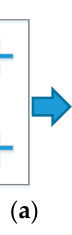
Figure 1. Overview of the hardware of the proposed embedded printed circuit board (PCB) alignment system. ( a , b ) are the top view and the front view of the vision alignment platform, respectively; ( c ) is the location of the PCB in the system; ( d ) is the description of the parameters of the movable platform (PL); and ( e ) shows the embedded-based controller using a NVIDIA Jetson Tx2 development kit.